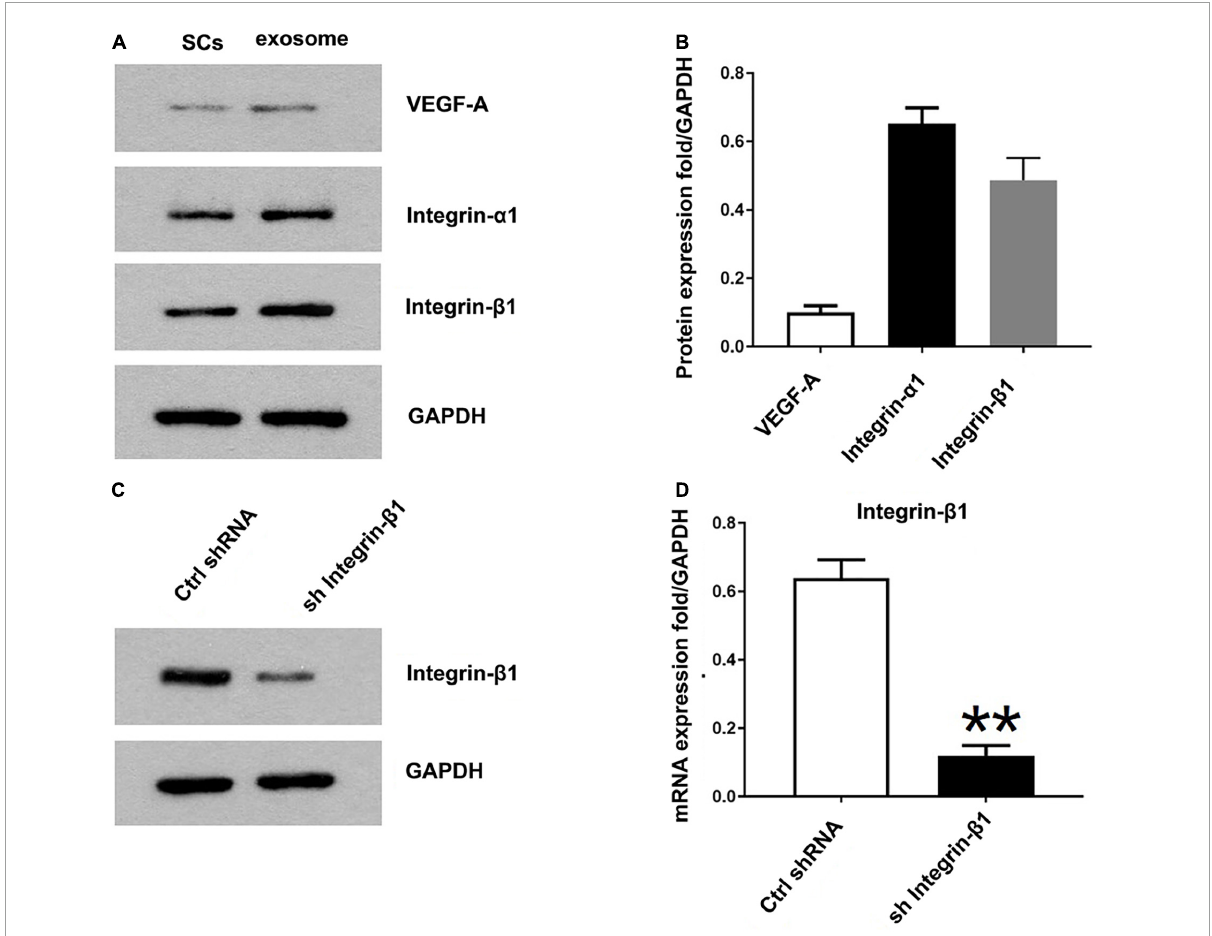
FIGURE3 Identification of the pro-angiogenesis molecules in SCs-Exos and the inhibitory efficiency of integrin- β 1 siRNA. (A) Western blotting was used to detect the protein level of VEGF-A, integrin- β 1 and integrin- α 1 in SCs and SCs-Exos. (B) The relative protein expression levels of VEGF-A, integrin- β 1 and integrin- α 1 in SCs-Exos (C,D) . Western blotting and qRT-PCR were performed to analyze the inhibitory efficiency of integrin- β 1 siRNA. The data are presented as mean ± SD. ** p < 0.01 sh Integrin- β 1 group vs. ctrl shRNA group. N = 3 in each